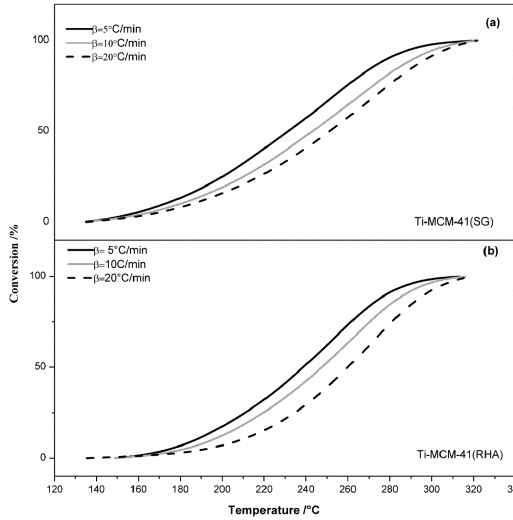
Figure 2. Conversion curve versus temperature of the Ti-MCM-41 (a) (SG) and (b) (RHA) (with heating rates of 5, 10, 20 °C / min –1 ).